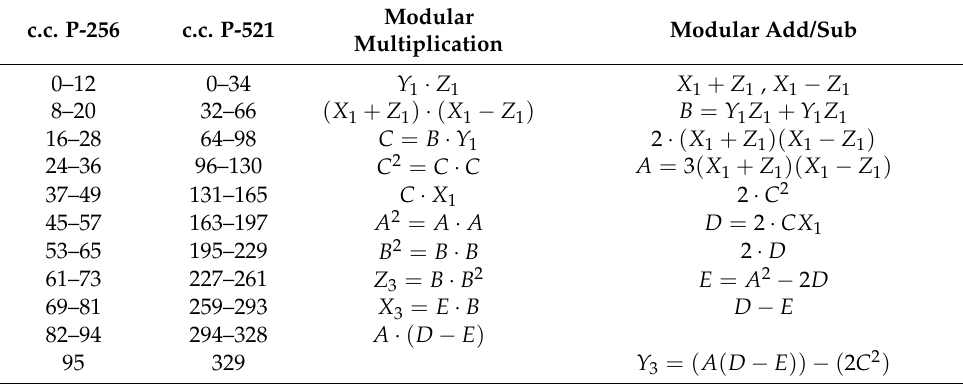
Table 3. PD Operations Scheduling (c.c. stands for clock